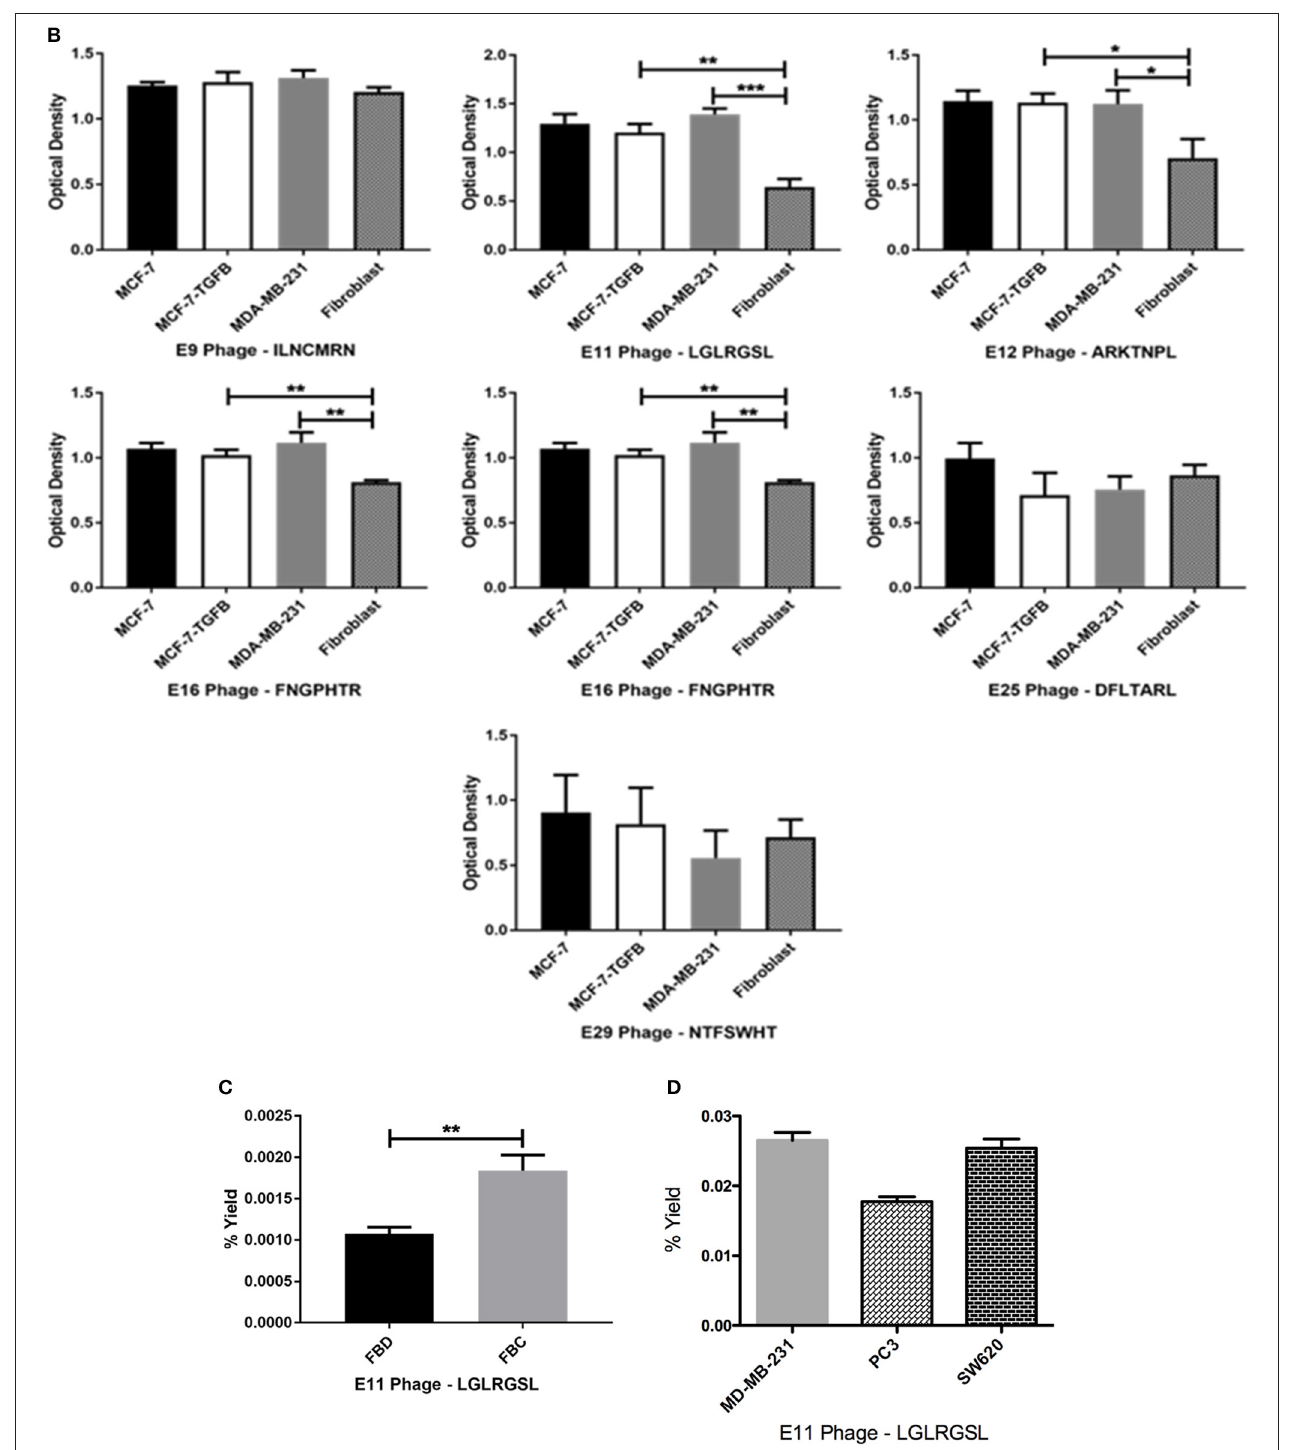
FIGURE 3 | Affinity selected eluate and lysate phage showed higher binding to MCF-7-TGF β , MDA-MB-231, T47D-shNMI cells as compared to breast fibroblasts, T47D and MCF-7 cells in (A) phage capture assay; (B) in phage based-ELISA; (C) LGLRGSL (E11) was also highly reactive to activated fibroblasts. FBD denotes fibroblasts in normal fibroblast media and FBC denotes fibroblasts in MDA-MB-231 breast cancer cell conditioned media and (D) LGLRGSL showed comparable binding to PC3 and SW620 cancer cells as compared to MDA-MB-231 cancer cells. All data represent the mean ± S.D. * p < 0.05, ** p ≤ 0.01, *** p ≤ 0.001, and **** p ≤